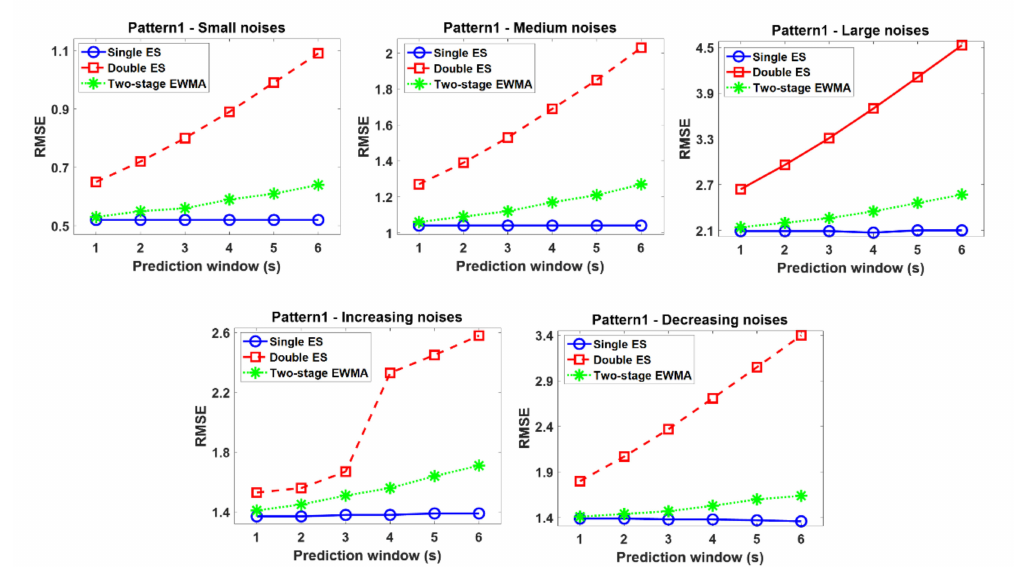
Figure 3. Comparison results between a single exponential smoothing (ES), double ES, and two-stage EWMA in Pattern